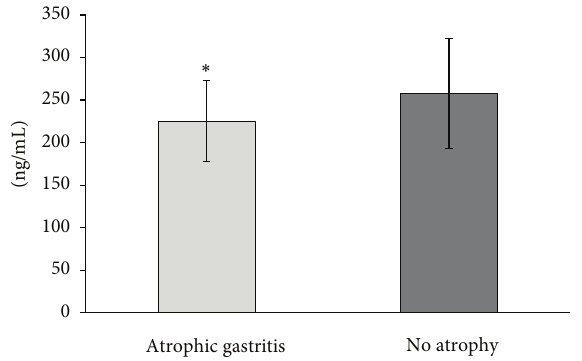
Figure 1: Serum prohepcidin levels in 35 atrophic gastritis patients and in 35 subjects without atrophic